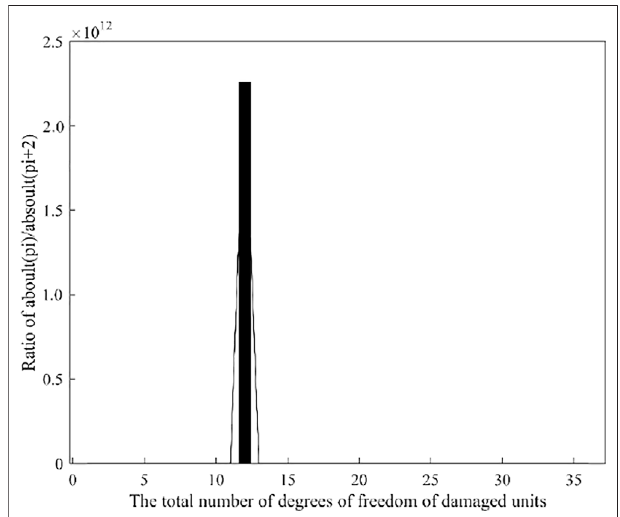
FIGURE 12 | Total number of freedom degrees of damage units.